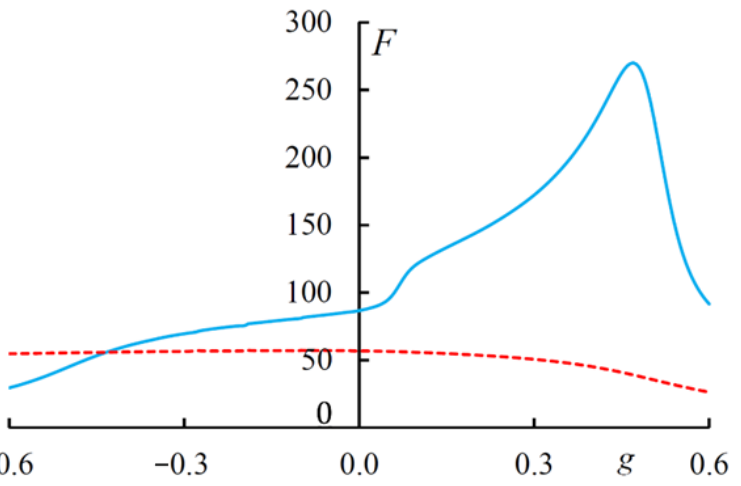
Figure 12. The light energy F versus parameter g . The incident light has a diffracting (solid line) and non-diffracting (dashed line) EP. 𝜆 1 = 20 nm and 𝜆 2 = 320 nm.